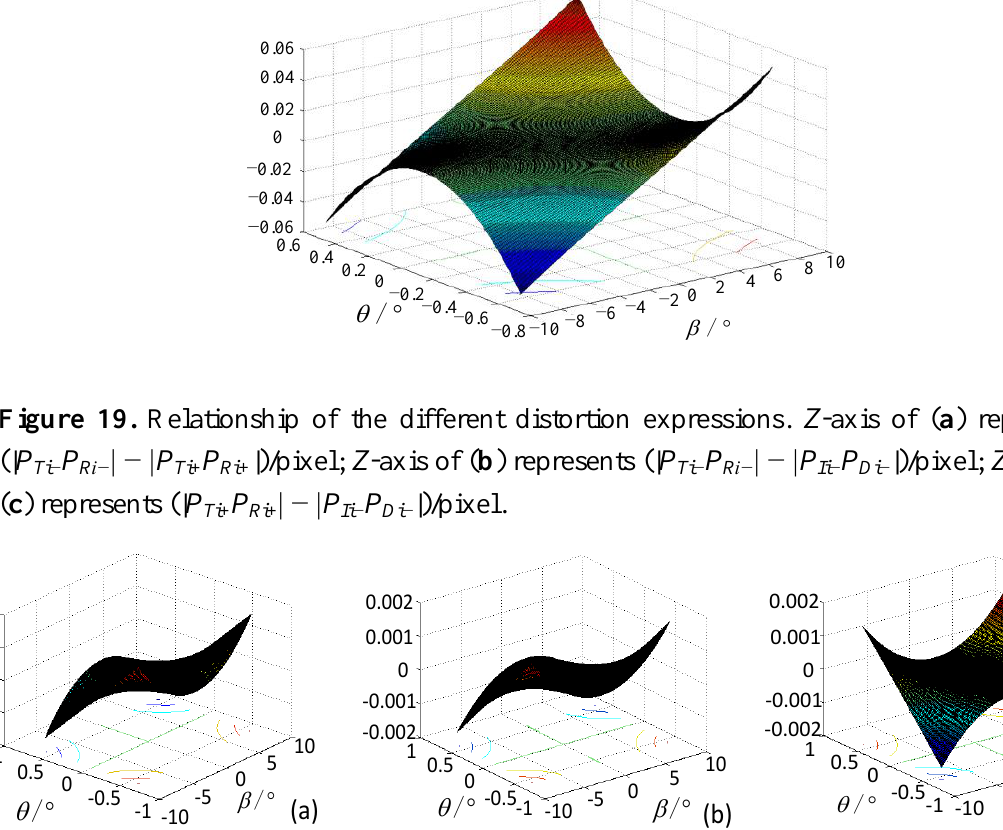
Figure 18. Error between the ideal and real distances of the symmetric points. The Z -axis represents the value (| P